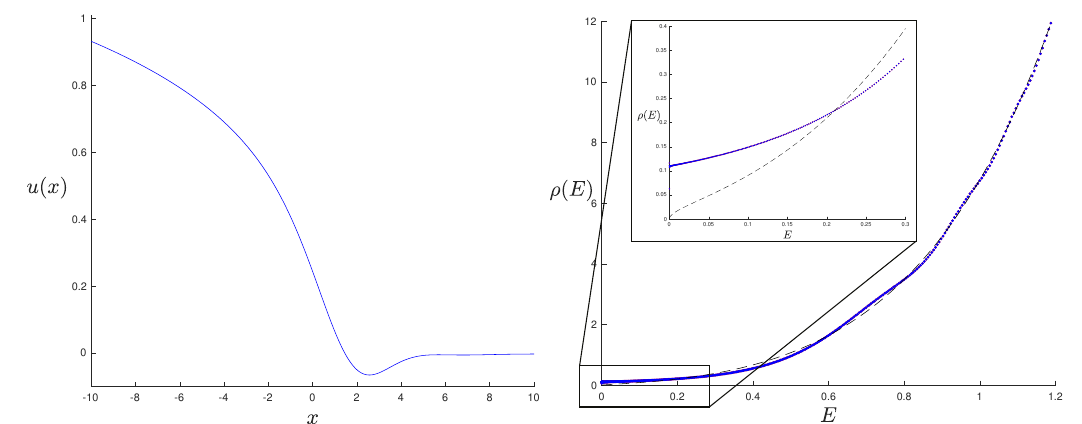
Figure 1. The non-perturbative potential (left) and spectral density ρ ( E ) (right) for JT gravity computed in ref. [27] using equation (2.15), truncated to k = 7 . The dashed line is the disc level result for ρ 0 ( E ) given in equation (2.13). The inset shows the region near the origin, displaying a non-zero ρ ( E = 0) . Here, ~ is set to